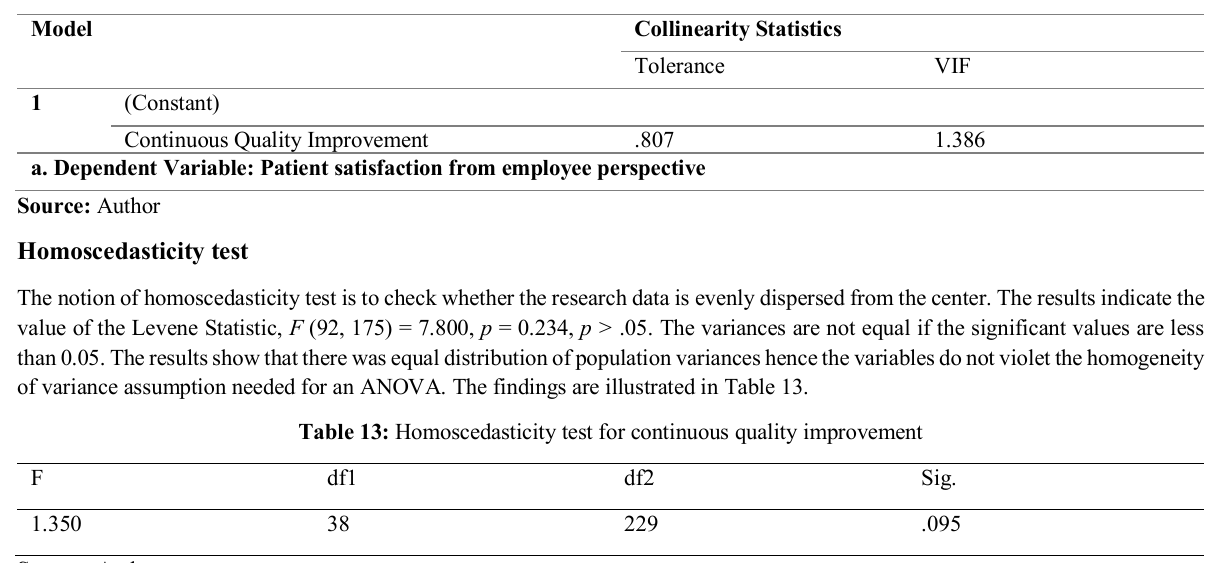
Table 12: Multicollinearity test